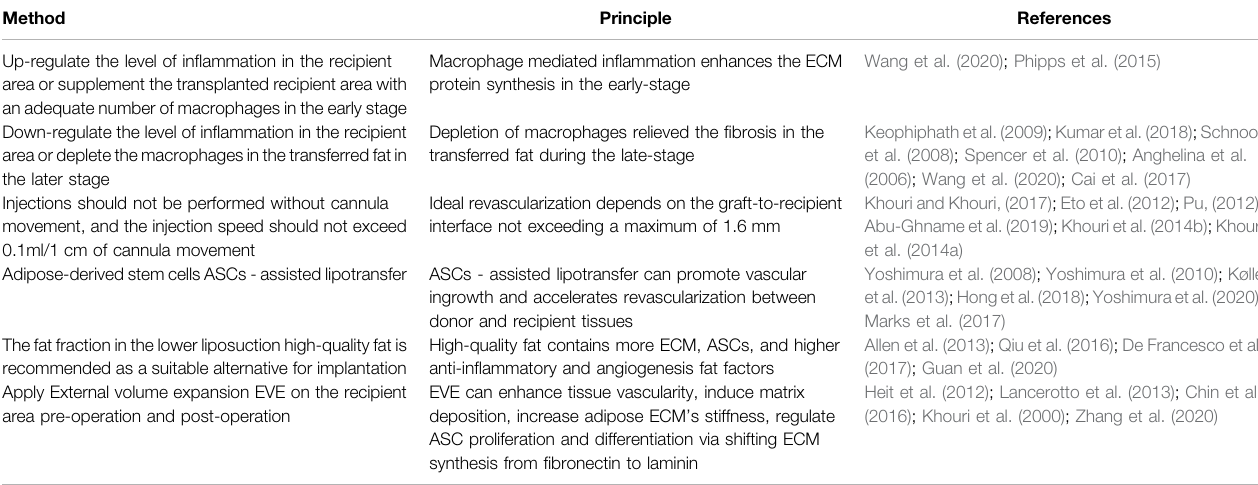
TABLE 1 | Clinical avoidance of poor ECM remodeling after